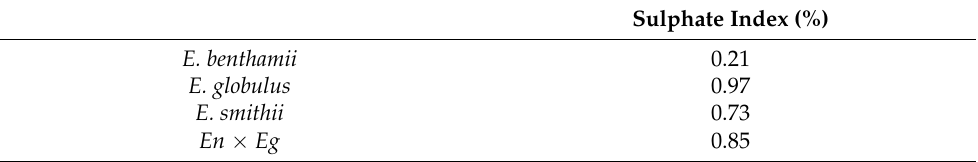
Table 2. Sulphate index of the CNCs obtained from the different eucalyptus